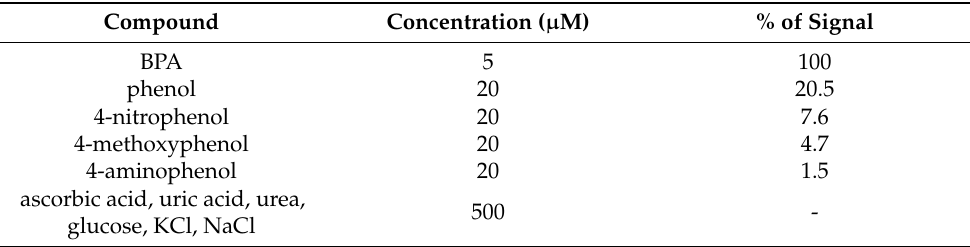
Table 2. Selectivity of the amperometric PA6/PAH@AuNPs/Tyr biosensor for BPA.